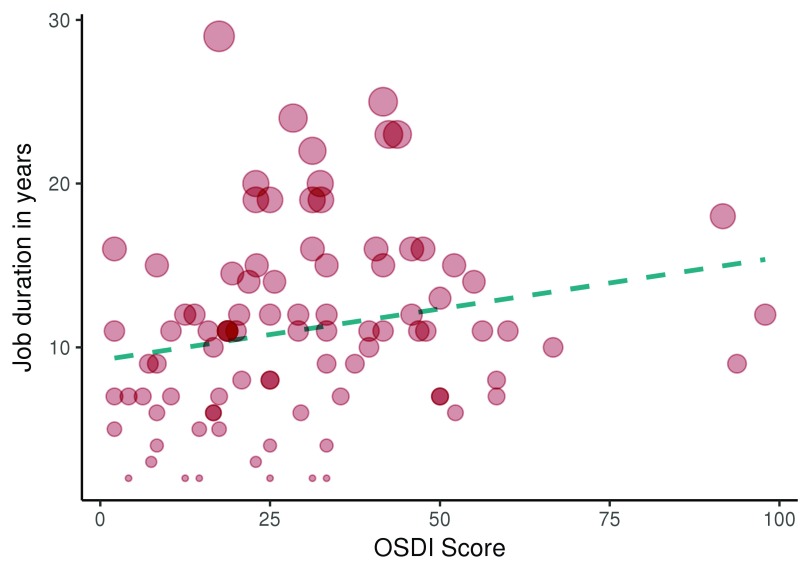
Correlation between OSDI and job duration.The circles in the graph are proportional to job duration (larger the circles longer is the job duration).